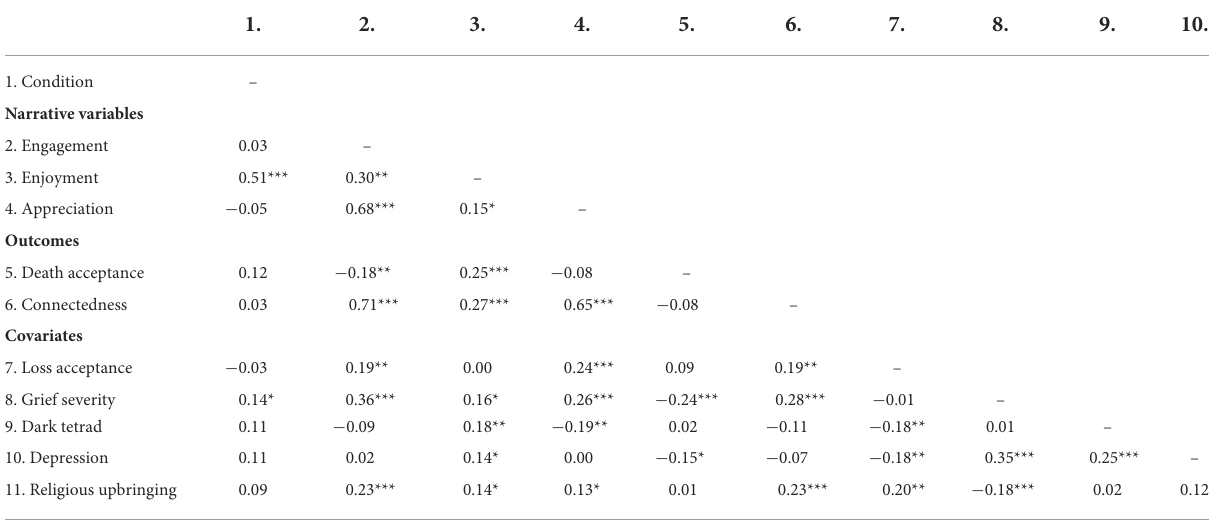
TABLE 1 Bivariate correlation matrix of measured